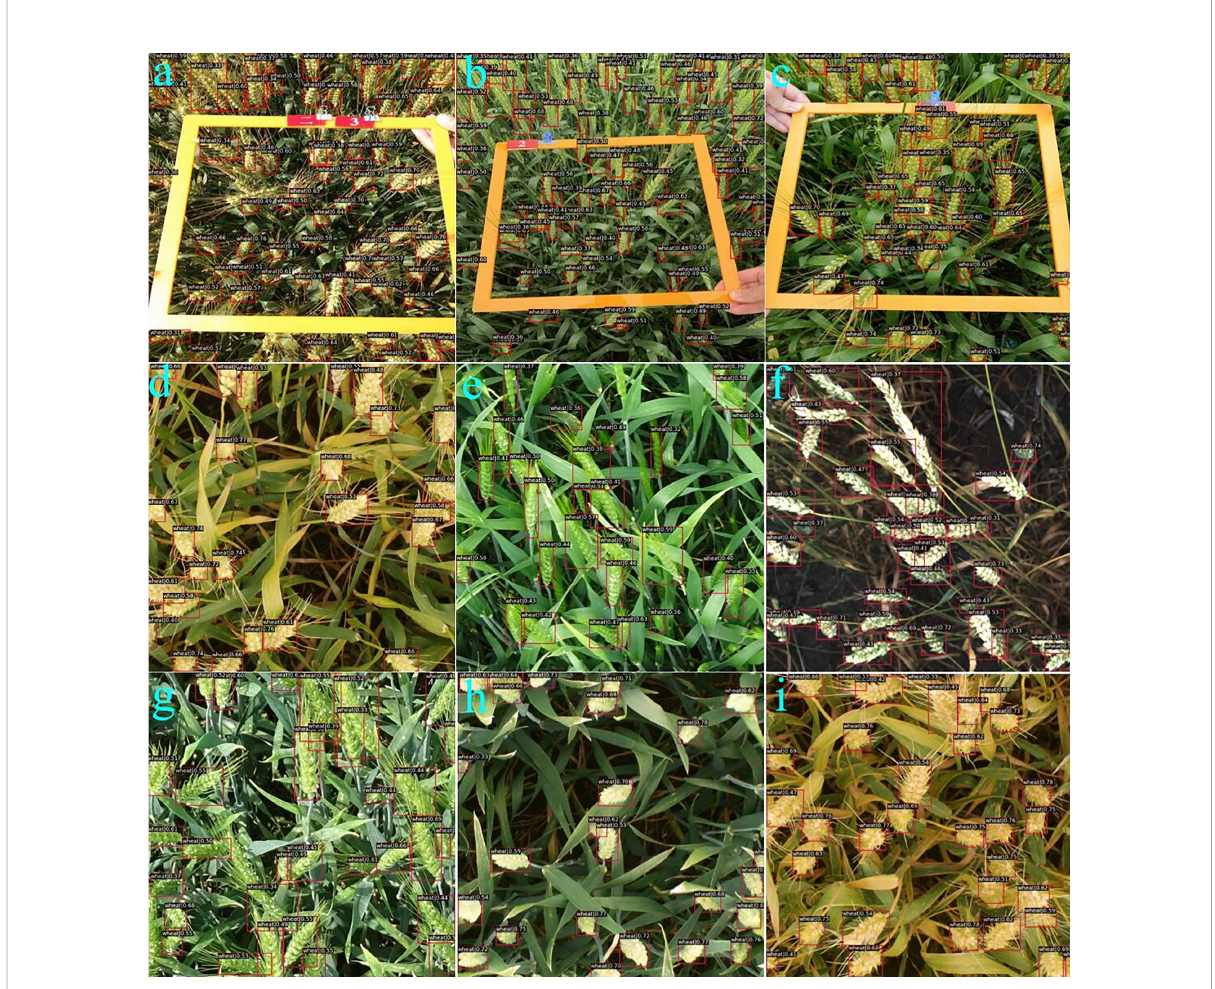
23 spikes per image, direct sunlight, and wheat ear group with 45° viewing angle of photographing, (F) the milk stage of maturity, 30 spikes per image, direct sunlight, and wheat ear group with 90° viewing angle of photographing, (G) poplar blossom, 27 spikes per image, direct sunlight,